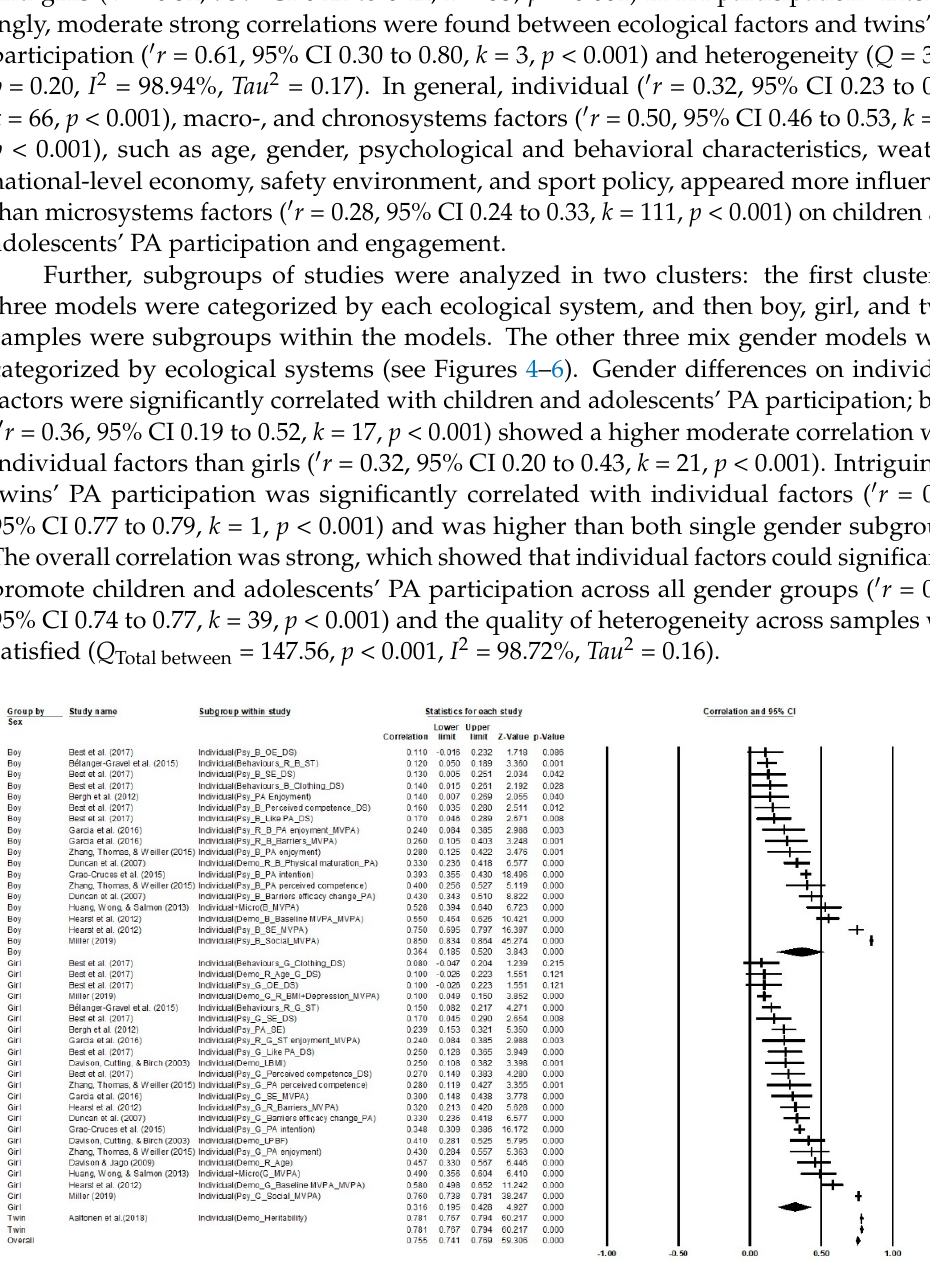
Figure 5. Aggregate correlations on microsystem factors in children and adolescents’ PA. Note. ASP = After school physical activity promotion; ATS = Active transport to school; B = Boy; CIM = Chil- dren independent mobility; DAP = During adolescent period; DS = Daily steps; R = Reversed corre-